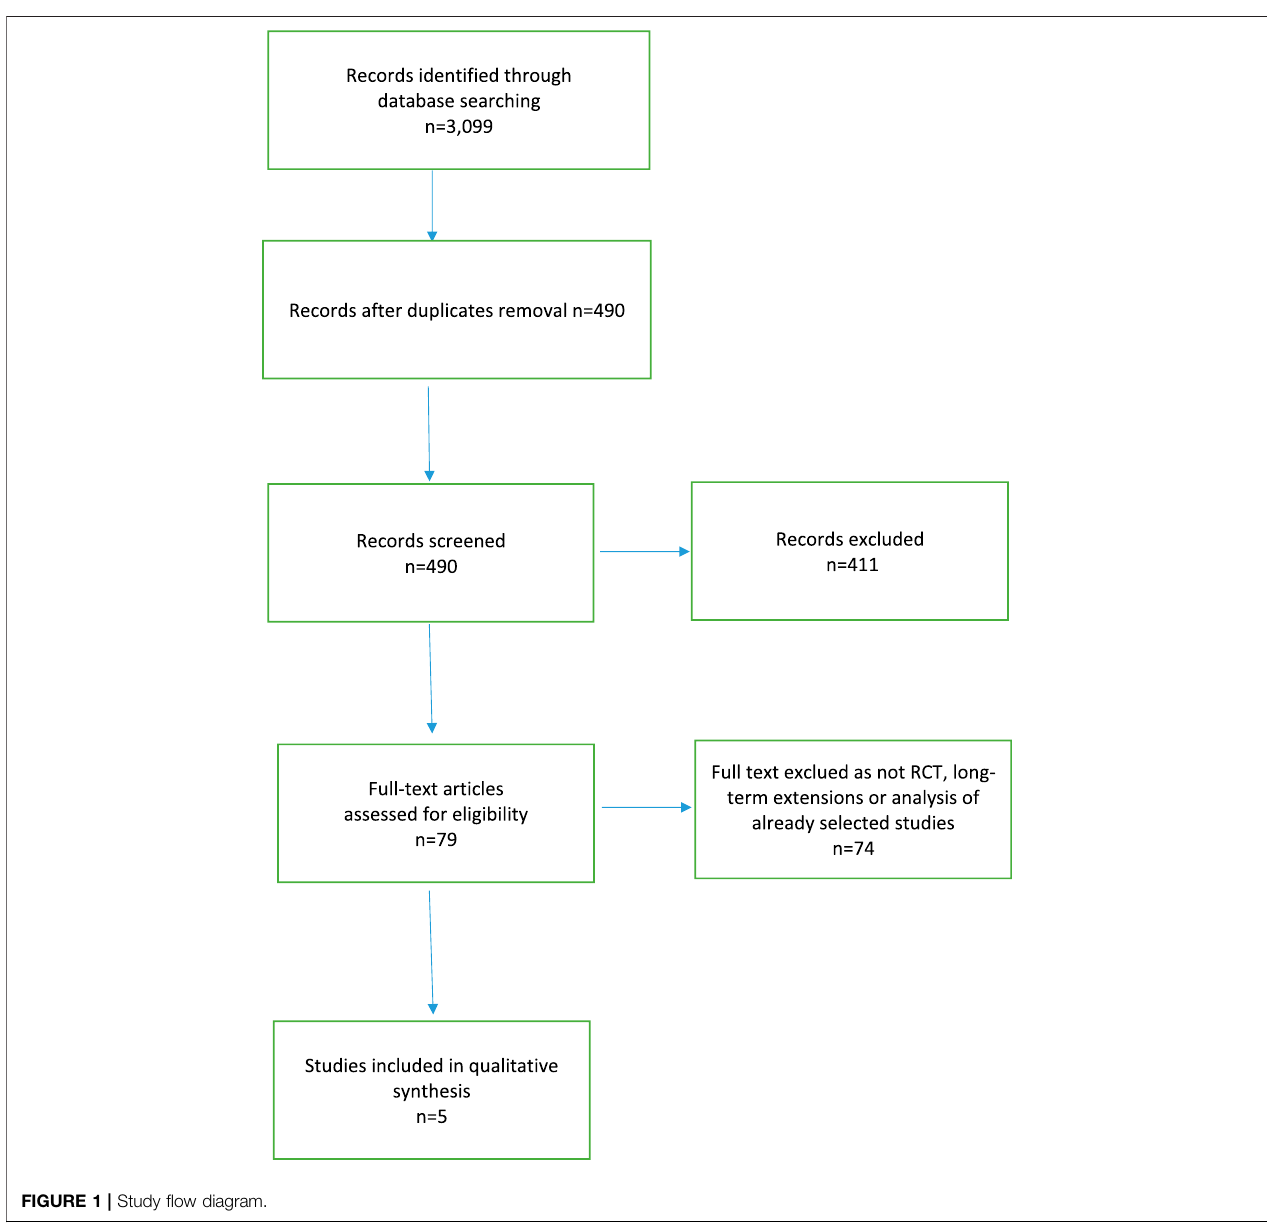
FIGURE 1 | Study fl ow diagram.